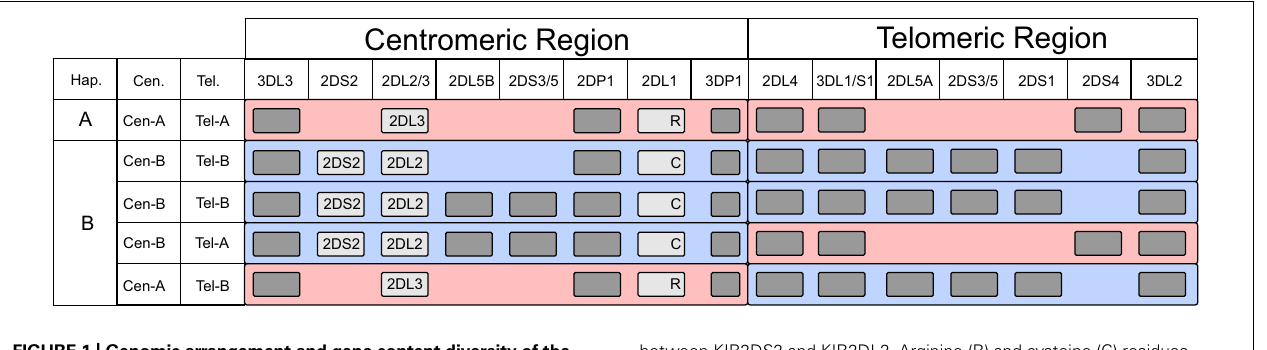
FIGURE 1 | Genomic arrangement and gene content diversity of the human KIR locus. Gene content of common KIR haplotypes is depicted schematically: gray boxes indicate presence of the specified KIR gene; KIR2DS2, KIR2DL2, and KIR2DL3 are specifically identified to highlight the apparent allelic relationship of KIR2DL2 and KIR2DL3, and to show the linkage